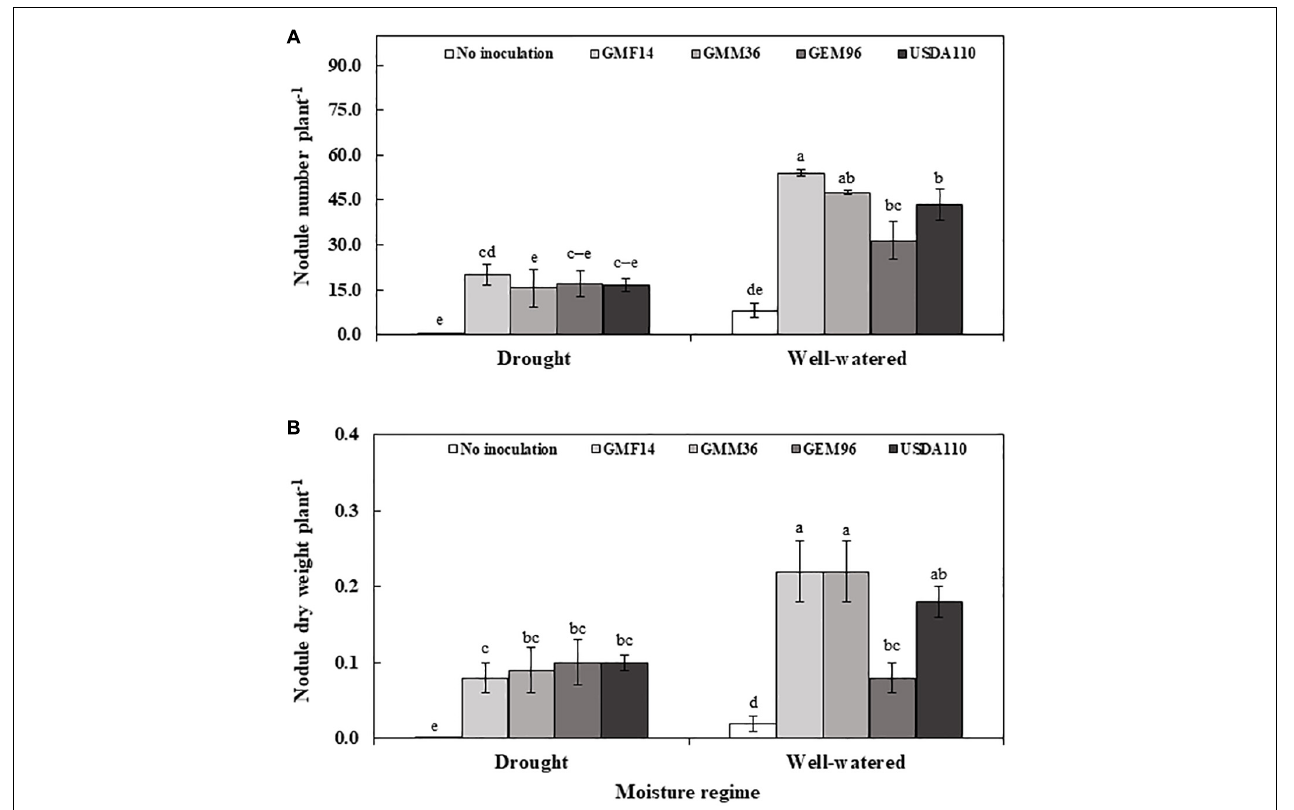
FIGURE 5 | Nodule number (A) and nodule dry weight (B) of soybean plant inoculated with different Bradyrhizobium strains in two moisture regimes in the second greenhouse experiment. The error bars are standard deviation of four replications ( n = 4). Values followed by the same letters on each bar are not significantly different at P ≤